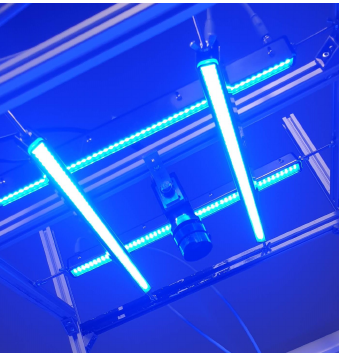
Figure 3. Photograph of the lighting as configured for bright field illumination (including the same bar lights as those used for dark field).